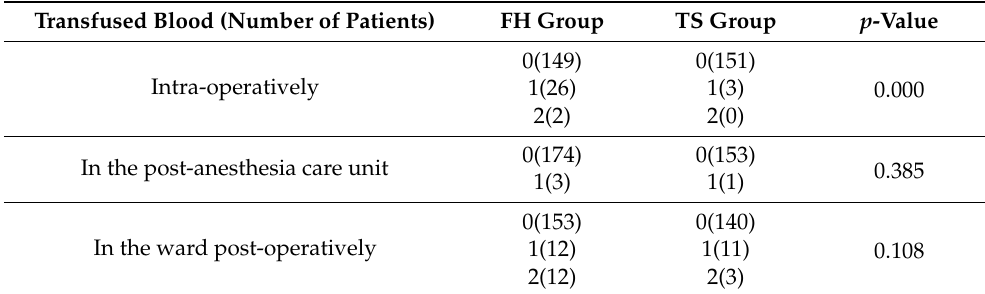
Table 4. Transfused blood units during and after the